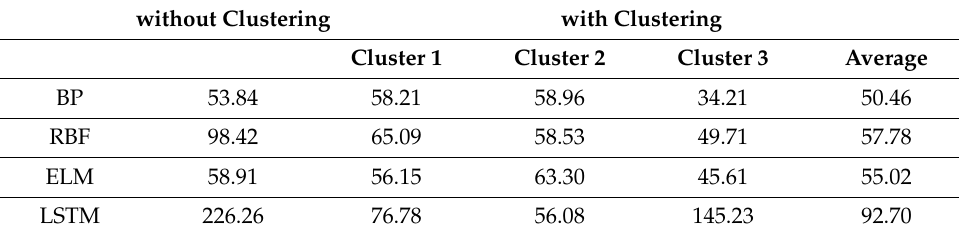
Table 1. RMSE of solar radiation forecast errors in spring.